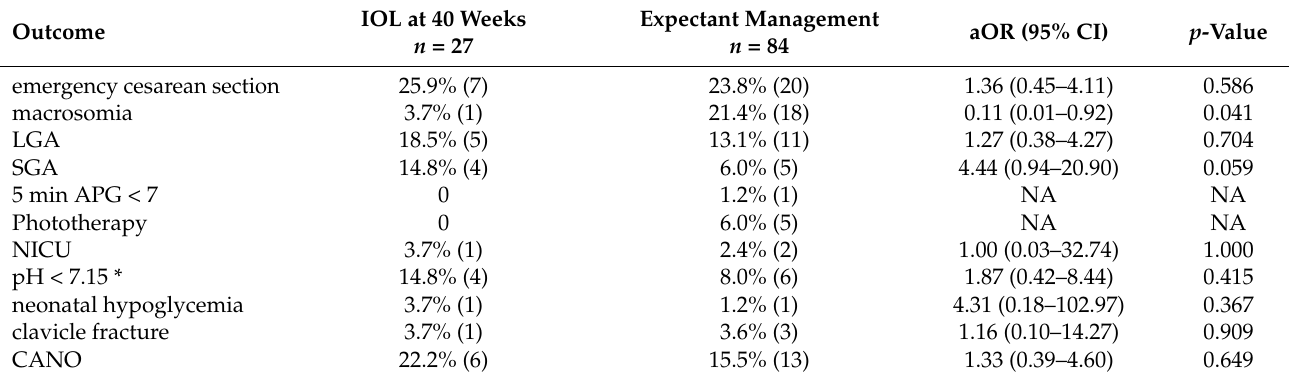
Table 5. Induction of labor at 40 weeks vs. Expectant management.